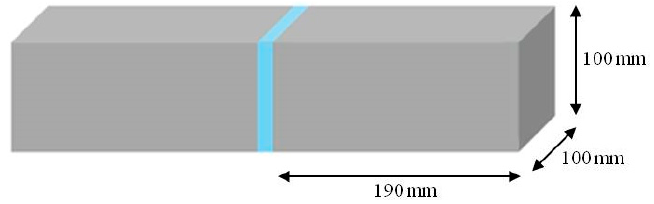
Figure 5. Dimensions of attached block specimen.